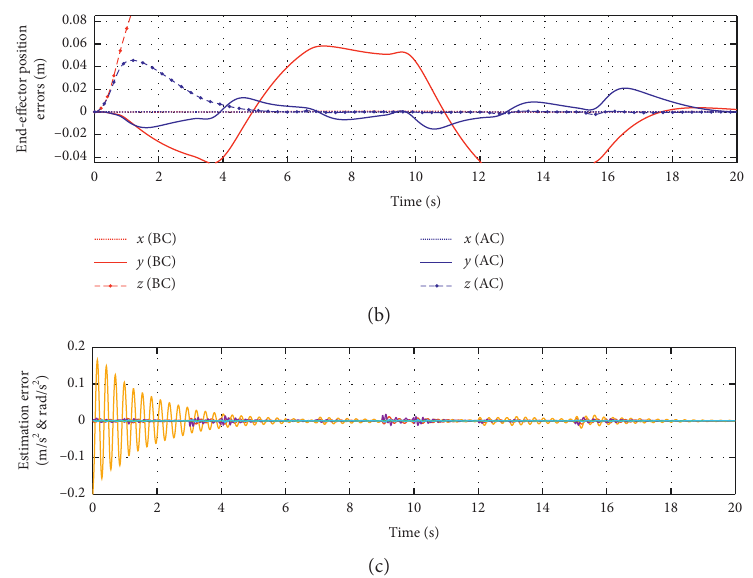
Figure 21: System responses in Scenario